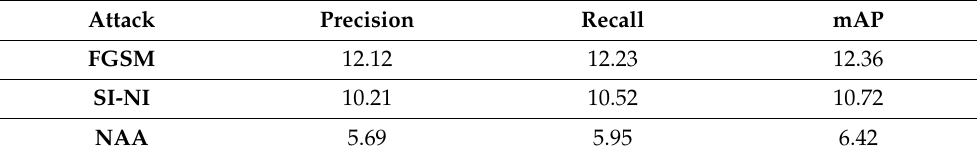
Table 3. Test of the detection effect on the test sets when no defence training is applied.